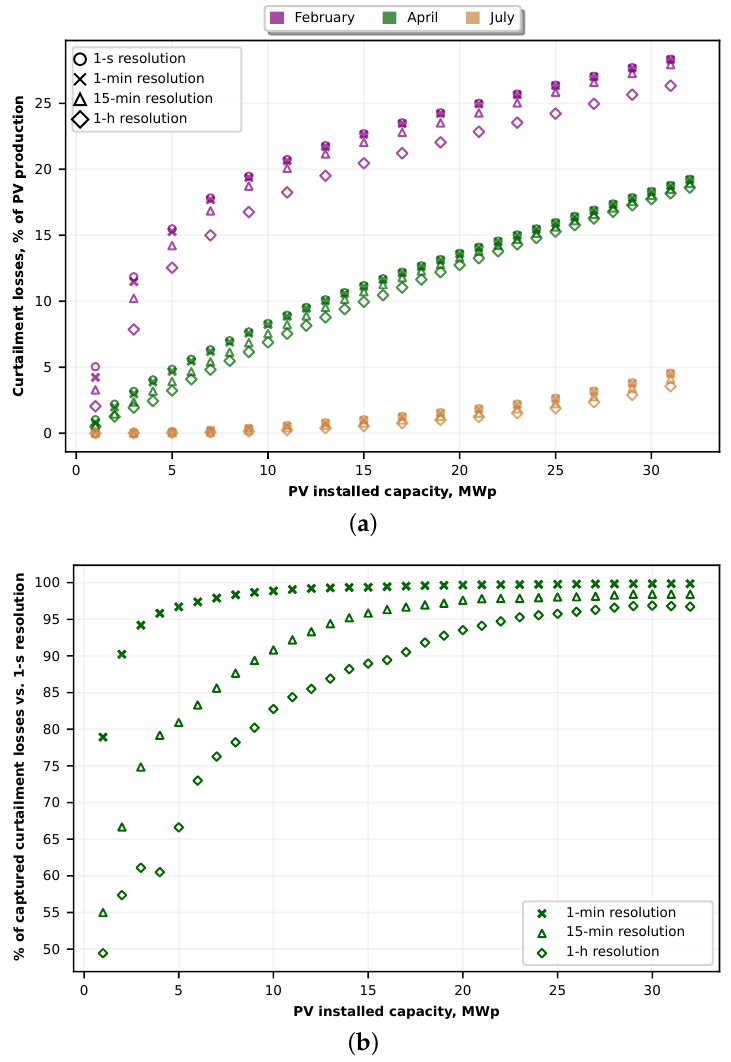
Figure 15. Curtailment losses when wind farm is expanded with solar PV farm with capacities in the range 1–32 MWp represented as ( a ) curtailment losses in % of PV production for February, April, and July and ( b ) captured curtailment losses as % of curtailment losses in 1 s resolution for April. For a 5 MWp PV plant, percentage-wise this is an increase from 3.2% in 1 h resolution to 4.8% in 1 s resolution. In contrast, curtailment losses captured with 1 min resolution are 79% for April and 84% for February in comparison to 1 s resolution. In the case